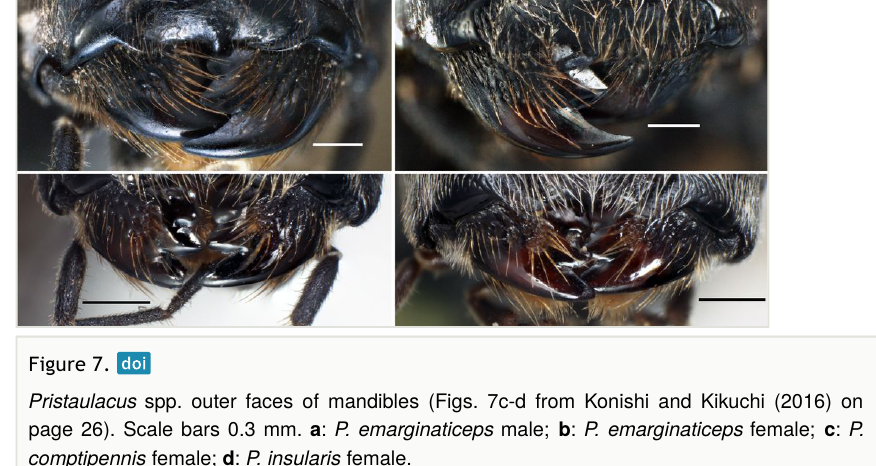
Legs: Coxae setose; fore coxa smooth; mid and hind coxae trans-striate on dorsal side; tibiae and tarsi with dense setae and punctures; hind basitarsus 9.2–11.0 times as long as wide; tarsal claws with 6 tooth-like processes. Wings (Fig. 4): Fore wing 2.8–3.0 times as long as wide, apex rounded; hind wing weakly tapering toward rounded apex, 3.6–3.9 times as long as wide and with 4 distal hamuli. Metasoma pyriform in lateral view, shiny and covered with sparse setae and punctate; petiole 2.9–3.2 times as long as wide. Genitalia: Apical margin of subgenital plate emarginate medially (Fig. 5d); paramere subtriangular (Fig. 5a-b); cuspis fi nger-like shape, moderately curved and its apex punctate (Fig. 5b); digitus triangular (Fig. 5b); penis valve slightly curved ventrally (Fig. 5c); basal apodeme of aedeagus weakly curved dorsally. Measurements. Body length 18.5–20.0 mm. Length of fore wing 13.6–14.1 mm. Measurement of female from Laos: Body length 16.3 mm. Length of fore wing 13.6 mm. Ovipositor 13.2 mm. Head 0.8 times as long as wide; malar space 0.3 times as long as eye height; POL/OOL = 1.4; antenna 3.6 times as long as head length; scape 1.6 times as long as wide; pedicel 2.2 times as long as wide; 1st fl agellomere 2.5 times as long as wide, 1.5 times as long as 2nd; hind basitarsus 7.9 times as long as wide; fore wing 3.0 times as long as wide, apex rounded; hind wing 3.9 times as long as wide; Petiole could not be measured because it was deformed; ovipositor 1.0 times as long as fore wing.